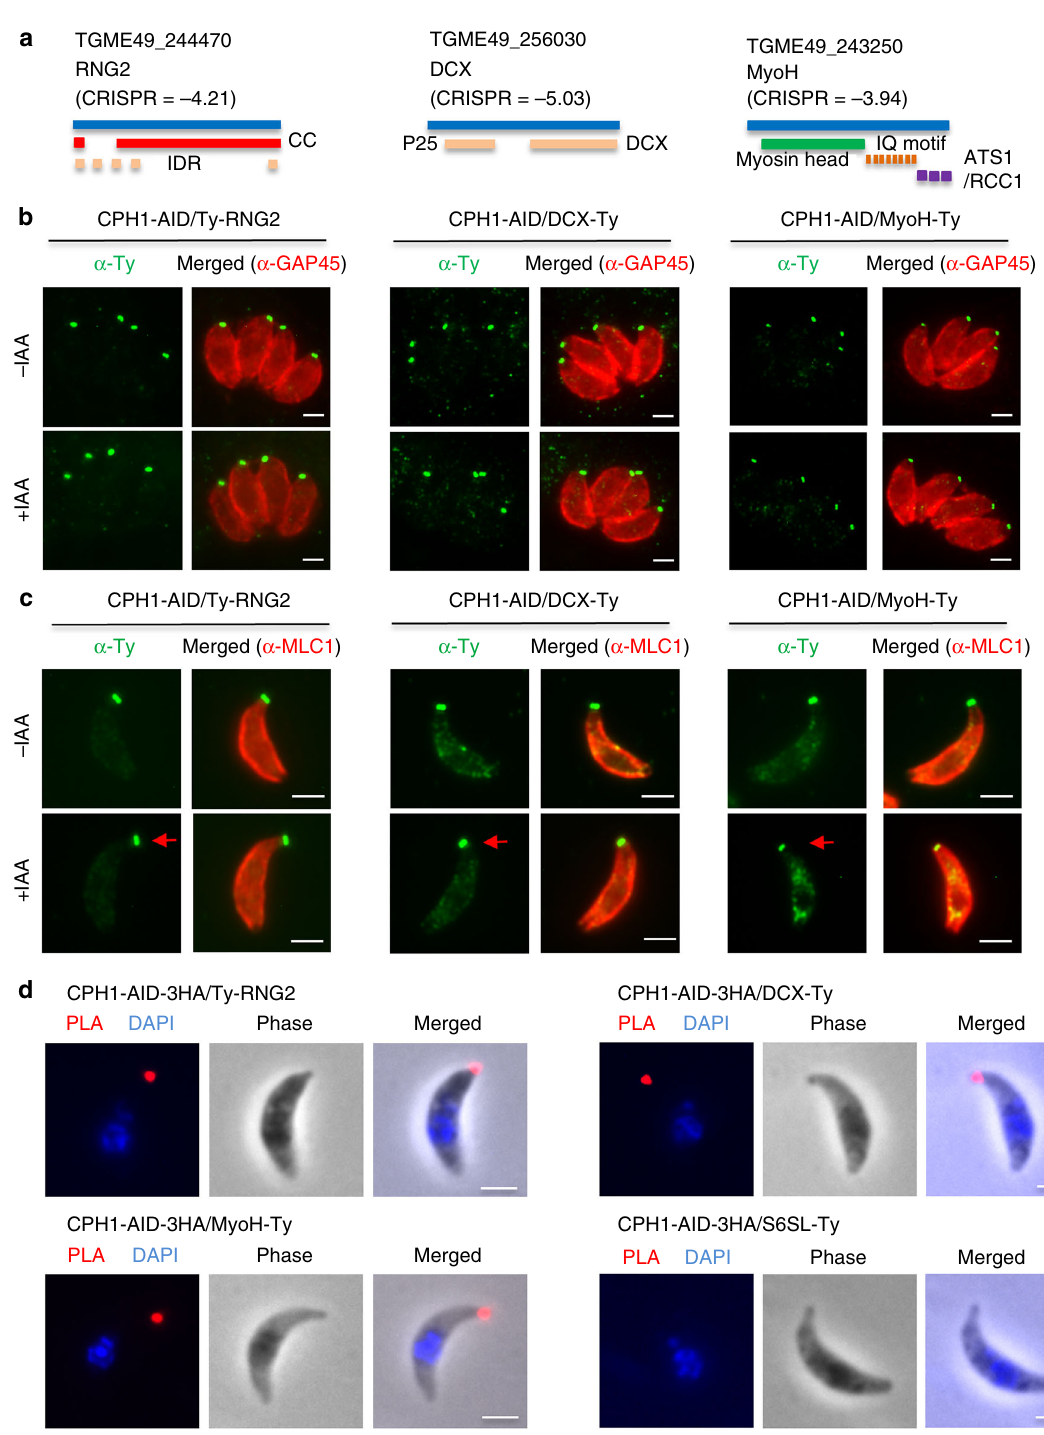
Fig. 6 CPH1 depletion has a minimal effect on protein stability of known conoid proteins. a Domain arrangements of RNG2, DCX, and MyoH as determined by InterPro. CRISPR fi tness scores were derived from ref. 32 . b Intracellular parasites grown in ± IAA for 24 h were stained with mouse anti-Ty (green) to detect the tagged proteins and rabbit anti-GAP45 (red) to outline the parasite followed by secondary antibodies conjugated to Alexa Fluor dyes. Scale = 2 μ m. c Extracellular parasites collected after natural or mechanical egress from cultures grown in ± IAA for 40 – 44 h were stained with mouse anti-Ty (green) and rabbit anti-MLC1 (red) followed by secondary antibodies conjugated to Alexa Fluor dyes. Red arrow indicates position of the conoid. Scale = 2 μ m. d Extracellular parasites were treated with 3 μ M A23187 to protrude the conoid, and stained with rabbit anti-HA and mouse anti-Ty antibodies, and followed with reagents for proximity ligation assay (PLA). S6SL is a pre-conoid protein. Phase, DAPI (blue) and PLA (red) are shown. Scale = 2 μ m. b – d Representative of three or more experiments with similar